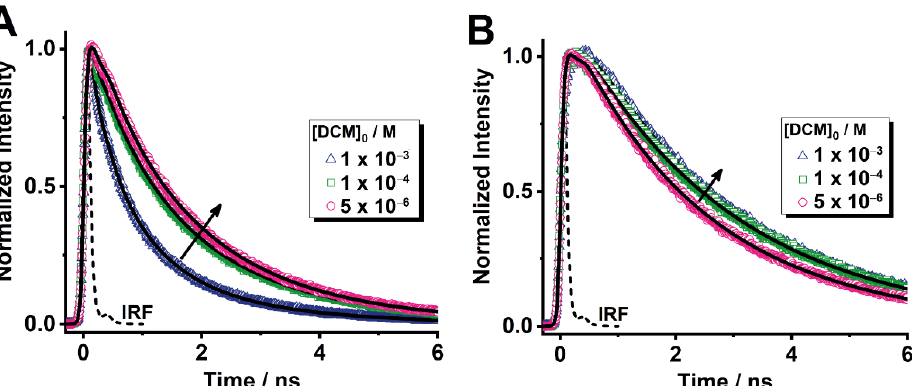
Figure 2. Normalized (to the maximum intensity) magic-angle emission decays of DCM/Al-ITQ-HB at different initial dye concentrations: 1 × 10 − 3 M (blue triangles), 1 × 10 − 4 M (green squares), and 5 × 10 − 6 M (pink circles) upon excitation at 470 nm and observing at 550–575 ( A ) and 700–750 ( B ) nm. The solid lines are from the best-fit using a multi-exponential function. IRF (black dashed line) is the instrumental response